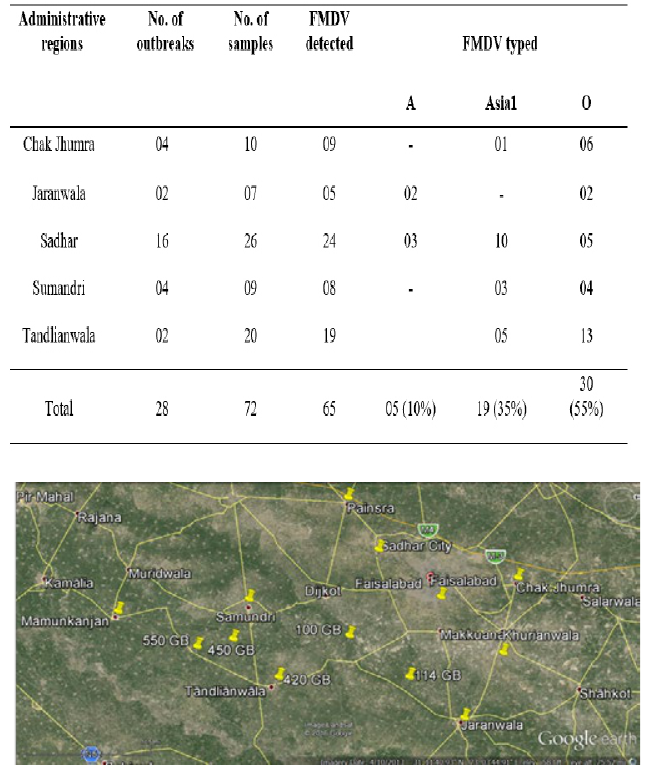
Figure 4. FMD outbreak location attended during this study are shown with place mark